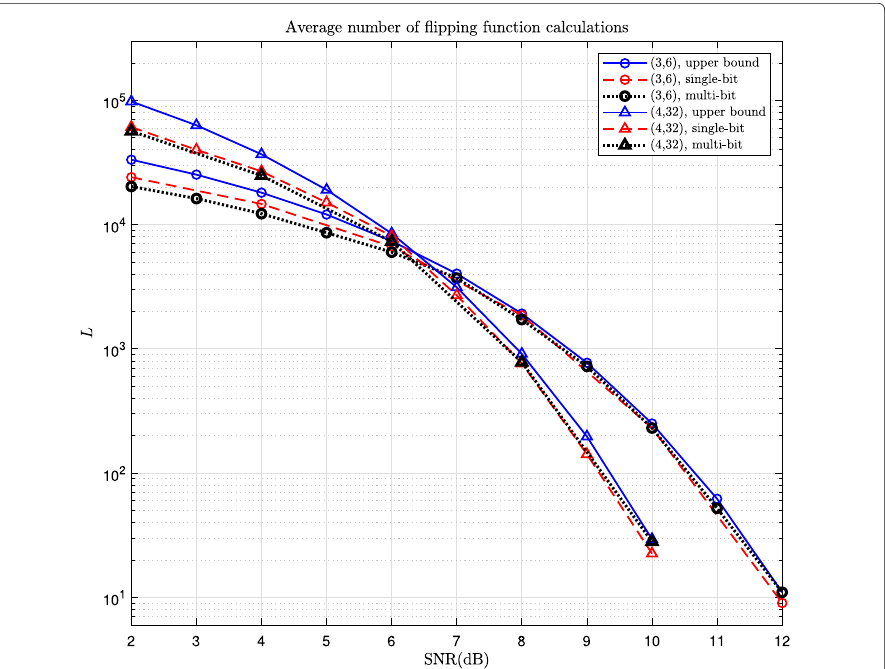
Fig. 3 L versus SNR for the (3,6) and (4,32)-regular LDPC codes with N = 10000 and 8176,